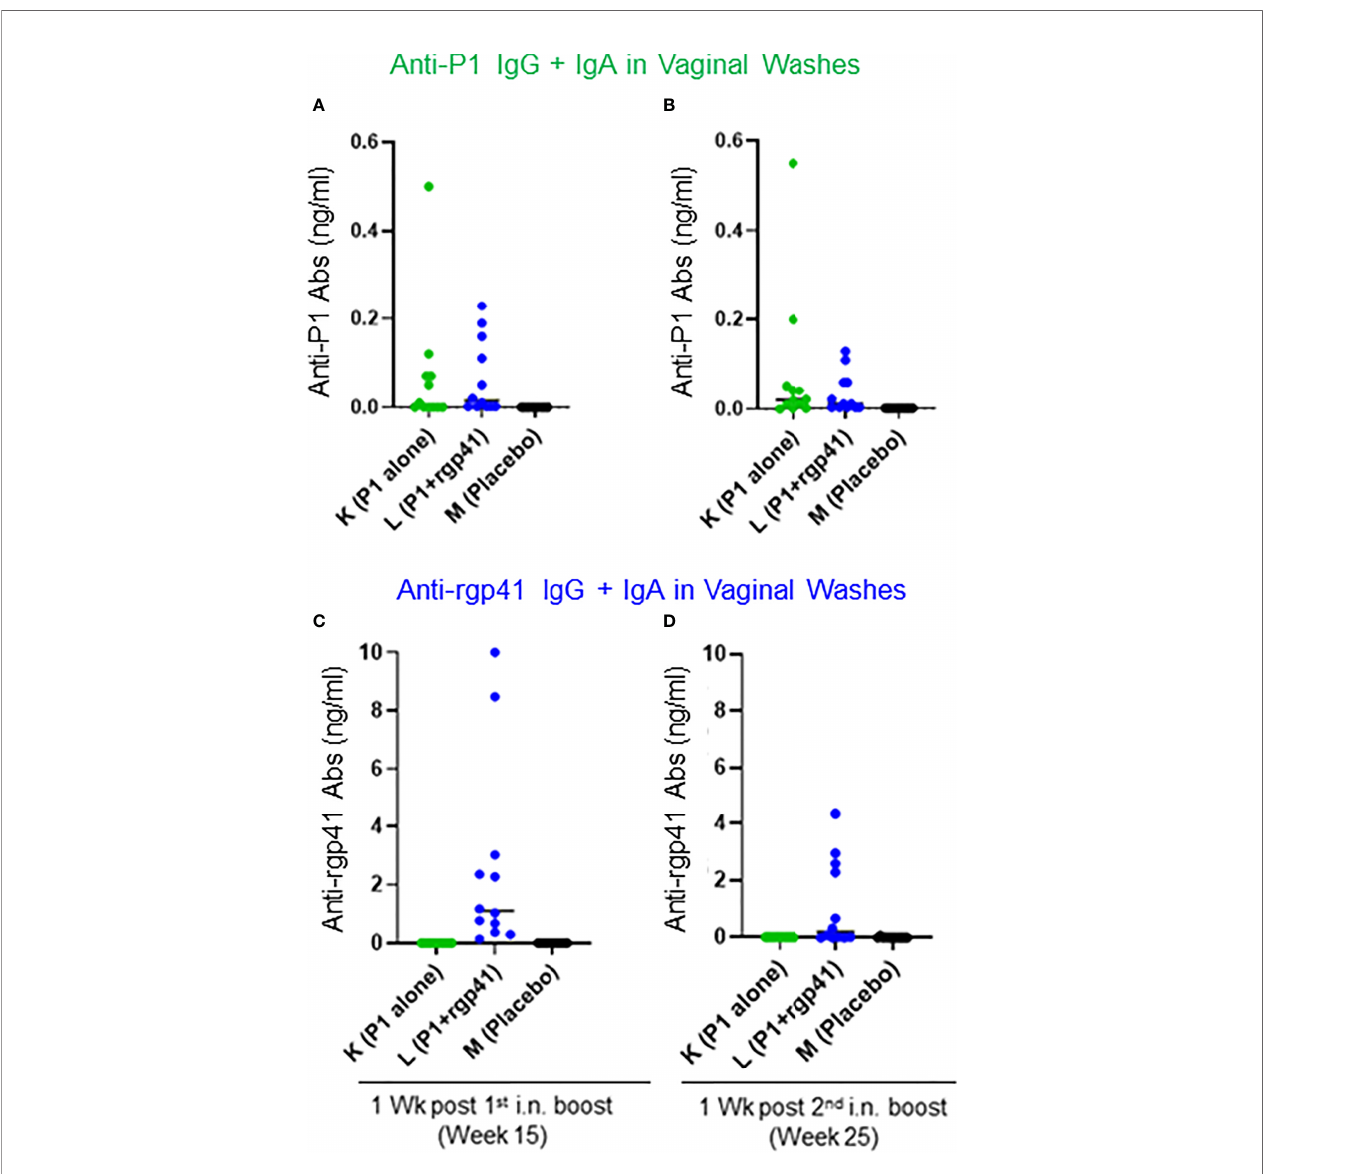
FIGURE 13 | Antigen-speci fi c antibody concentrations (ng/ml) measured in vaginal washes with the Imperacer ® assay (Methods). Group K (green circles) was immunized with single-agent virosome-P1 (P1 alone), Group L (blue circles) received the combination of virosome-P1 plus virosome-rgp41 (P1+rgp41), whereas Group M was given placebo virosomes (black symbols). (A – D) The sum of antigen-speci fi c IgG plus IgA is given at the weeks after intranasal (i.n.) boosts indicated; (A, B) anti-P1 responses, and (C, D) anti-rgp41